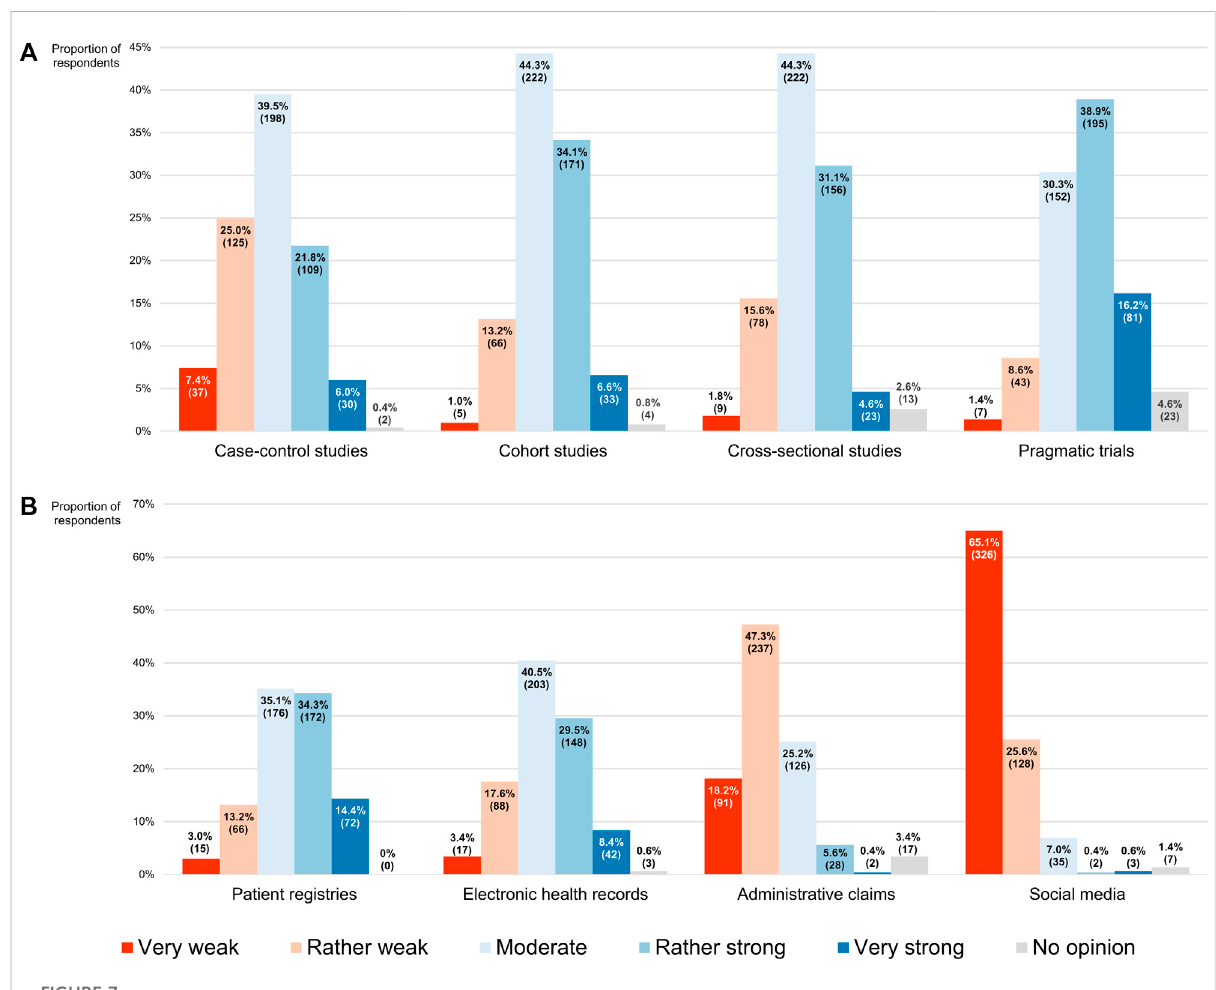
FIGURE 7 Participants ’ perceptions of the strength of the real-world evidence that can be produced by (A) different study designs, and (B) different sourcesofreal-worlddata.Thepercentagesshownforeachitemmaynotadduptoexactly100%duetorounding.Thenumbersinbracketsindicate the absolute number of respondents corresponding with each